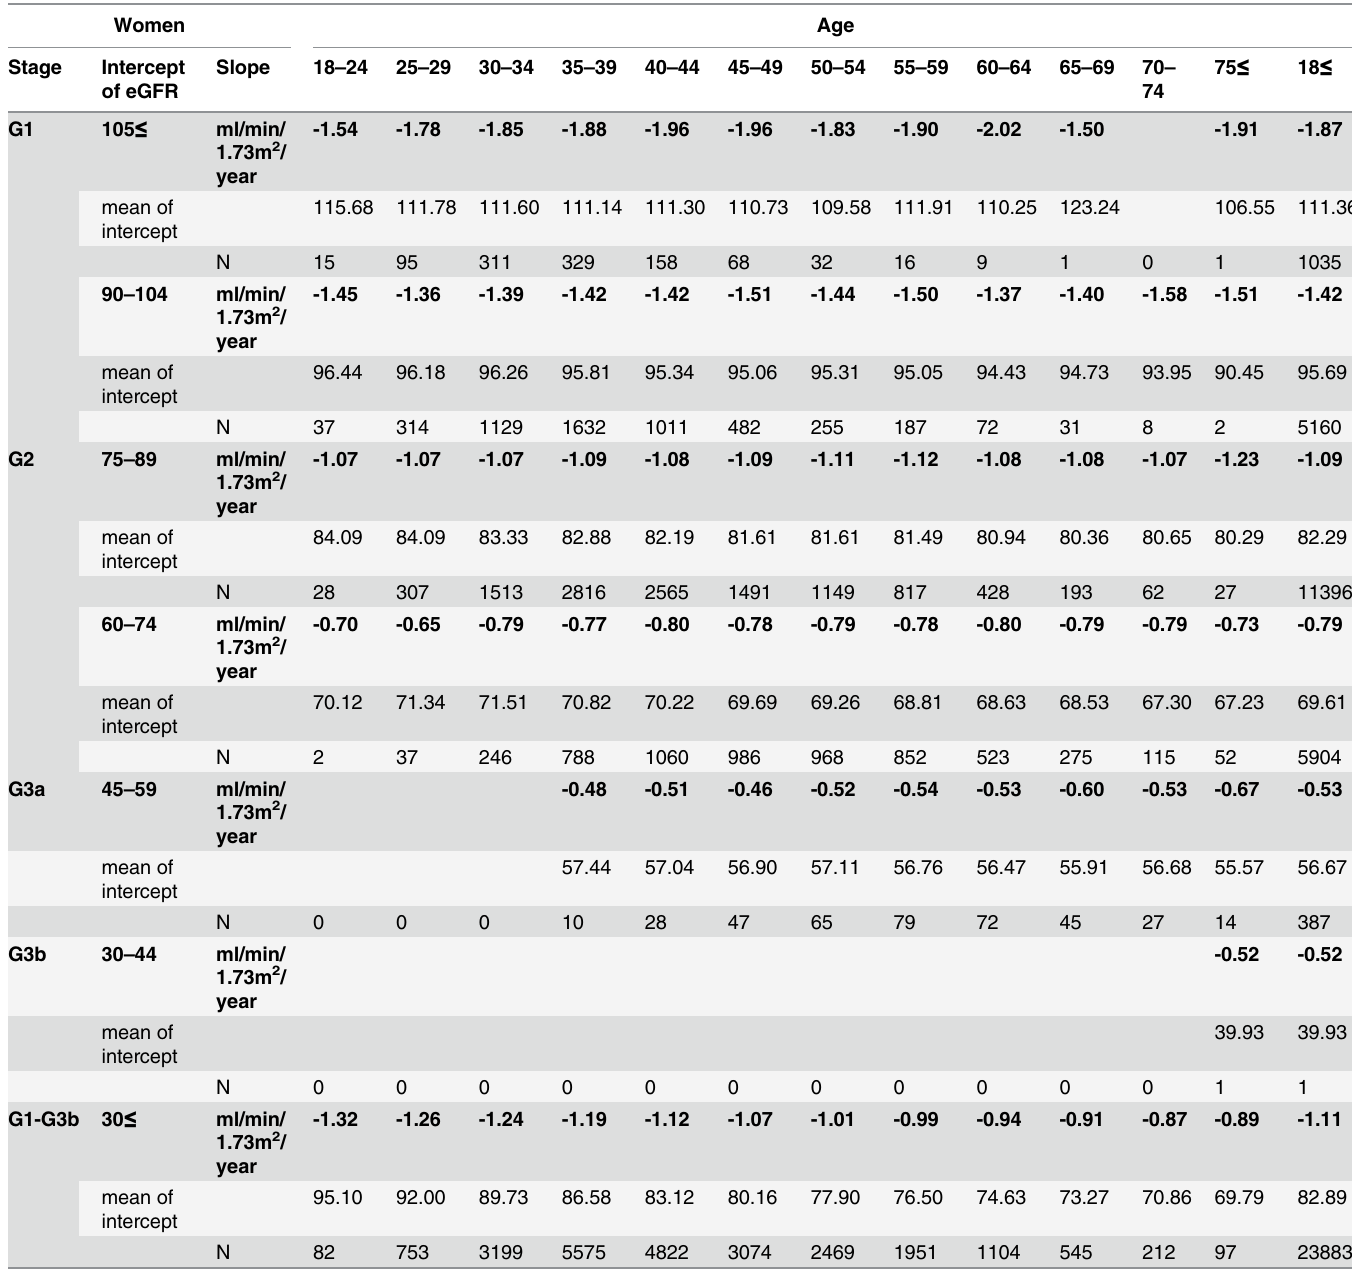
Table 4. Slope (ml/min/1.73m 2 /year) of eGFR decline in healthy